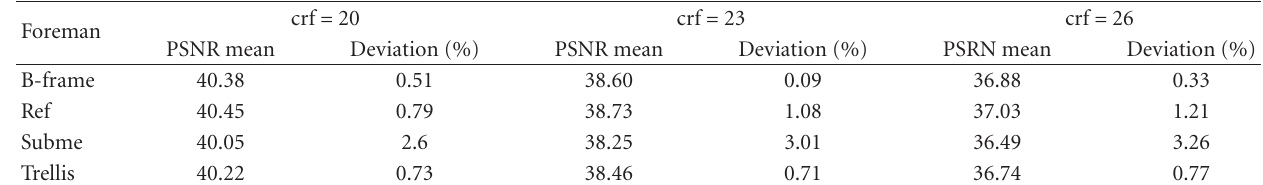
Table 1: PSNR versus CRF (foreman).